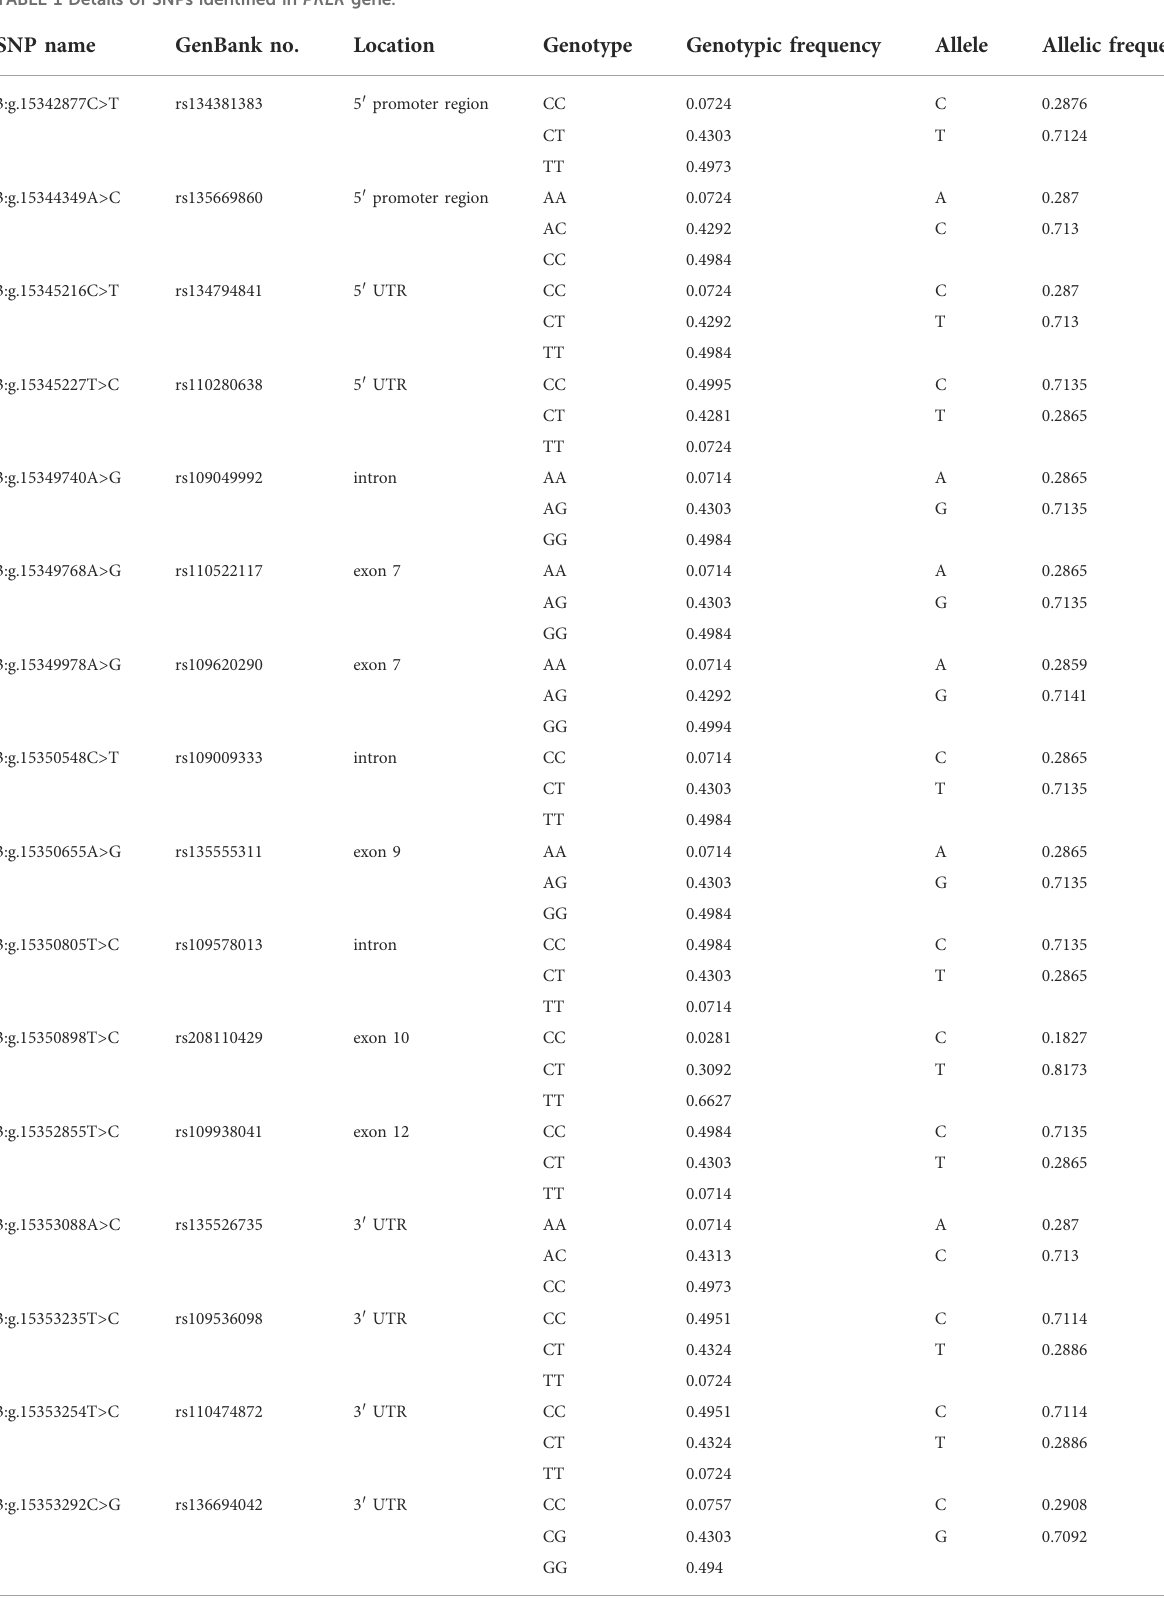
TABLE 1 Details of SNPs identi fi ed in PKLR